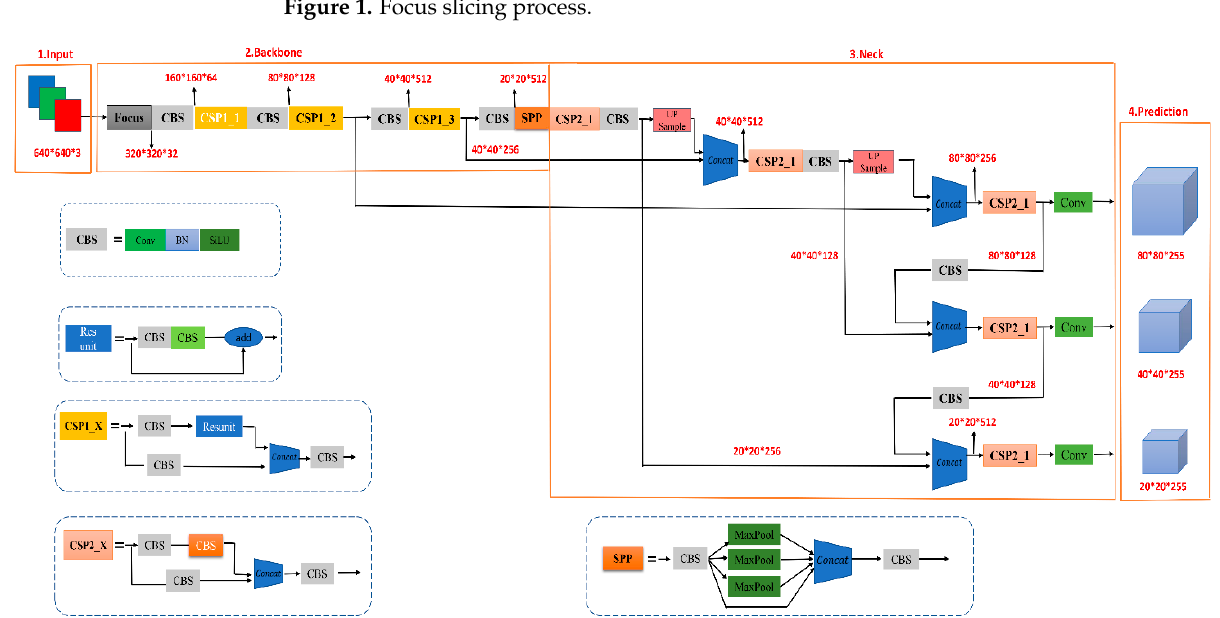
Figure 2. YOLOv5s network structure. It is mainly composed of four parts: input, backbone network, neck network, and prediction network.